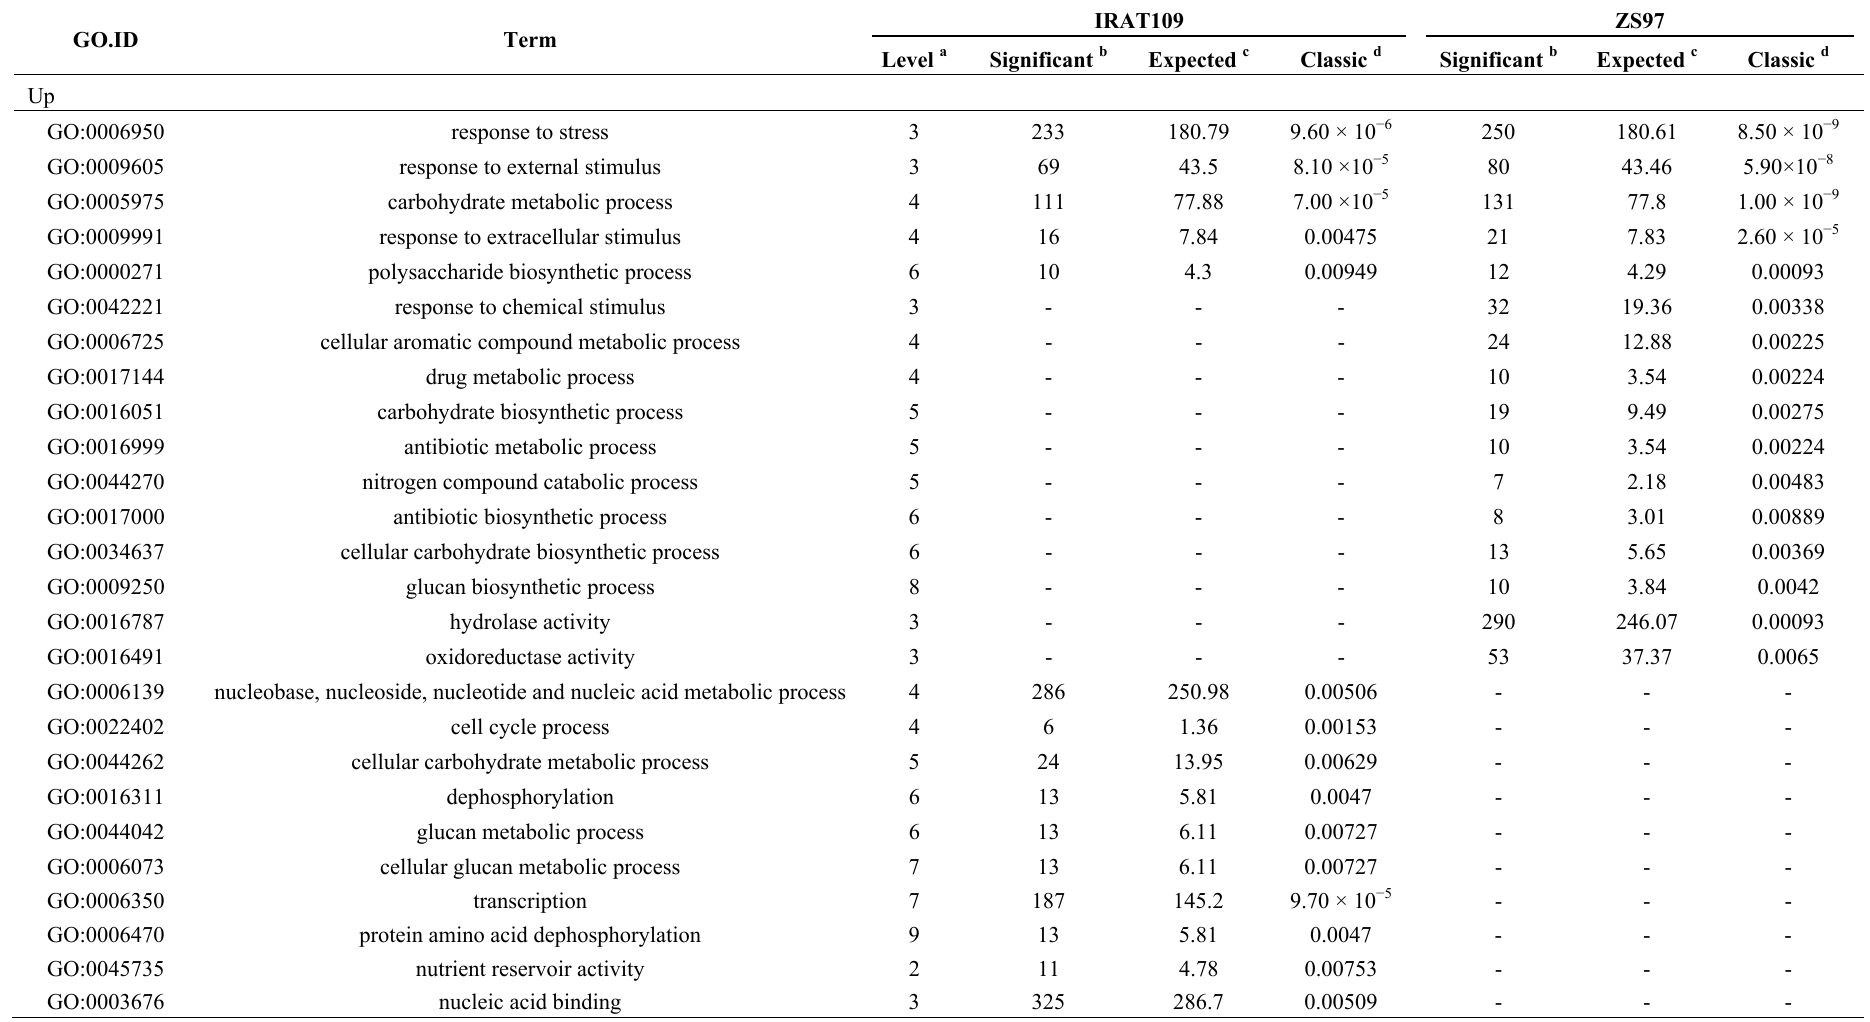
Table 2. Comparison of function categories of drought-responsive